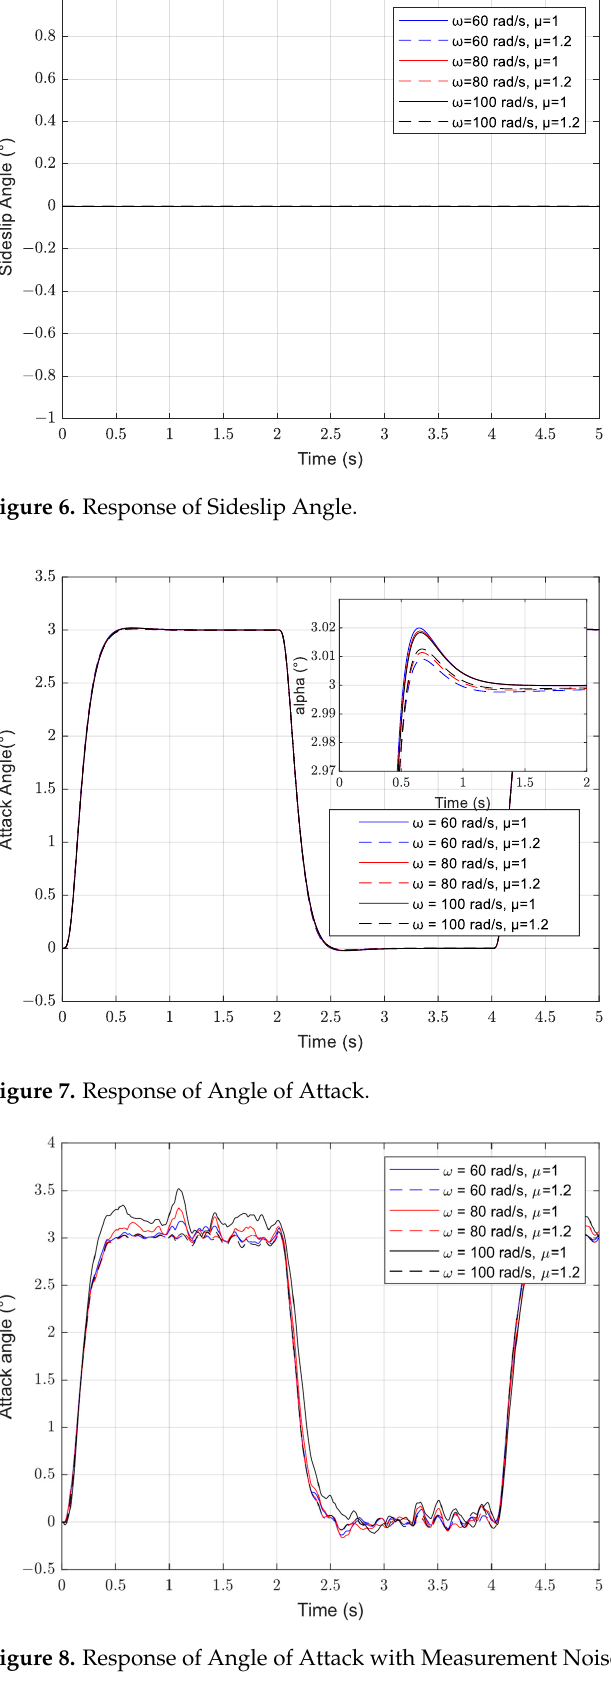
Figure 5. Response of Velocity Roll Angle.